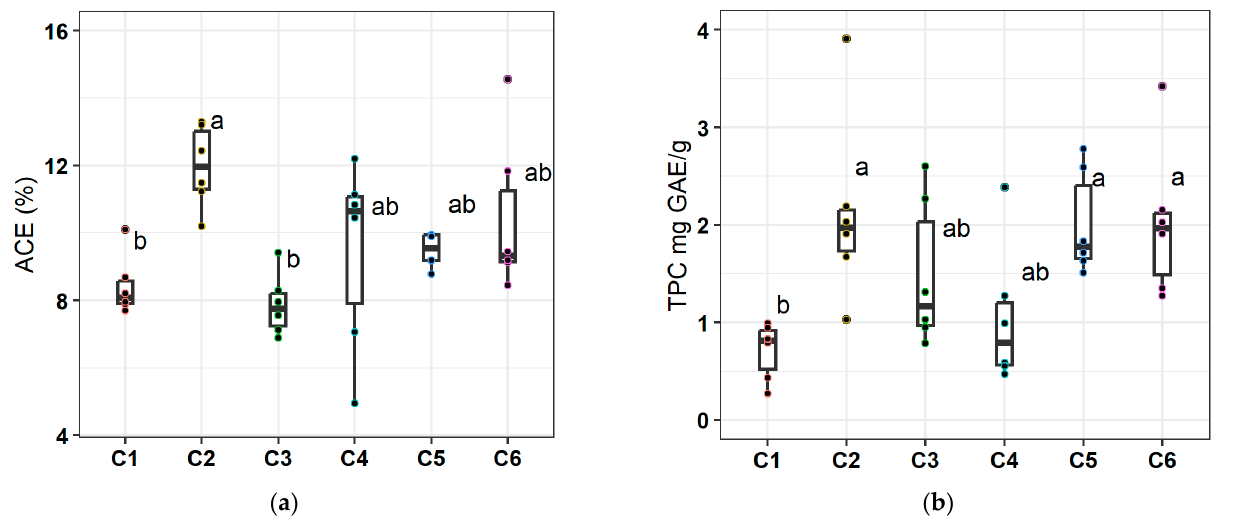
Figure 1. Variation in the content of ( a ) acemannan (% d.w.) in the inner leaf gel, and ( b ) total phenolic content (TPC; mg GAE/g) in the inner leaf gel, across treatments. C1 = control, C2 = organic fertilizer, C3 = BACTILLIS S, C4 = PGPR isolates, C5 = organic fertilizer plus BACTILLIS S, C6 = organic fertilizer plus PGPR isolates. The upper and lower box boundaries indicate the 75th and the 25th percentiles, respectively; the midline indicates the median, and the whiskers above and below indicate the 90th and 10th percentiles, respectively; the dots indicate outliers (n = 6). Boxes with different letter are significantly different according to Duncan’s multiple range test ( p <